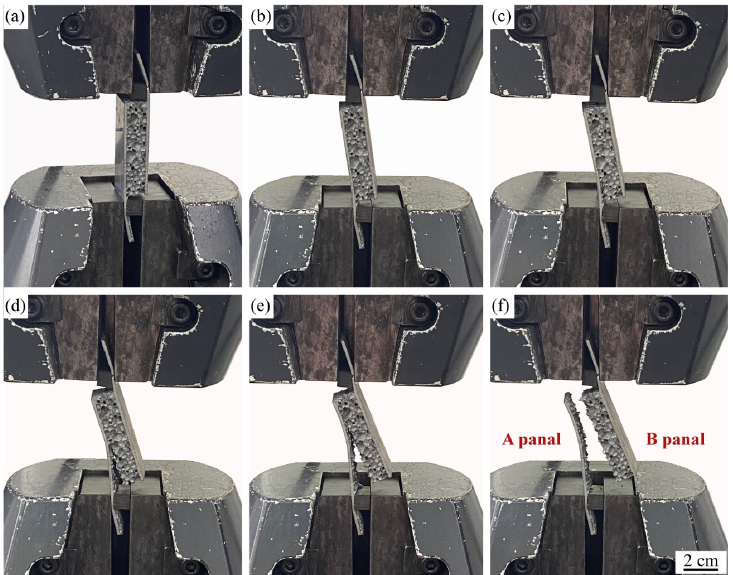
Figure 11. Series images of the panel peeling teat of metallurgical bonded AFS: ( a ) 0 mm, ( b ) 0.8 mm, ( c ) 1.6 mm, ( d ) 2.4 mm, ( e ) 4.0 mm, ( f ) 5.1 mm;